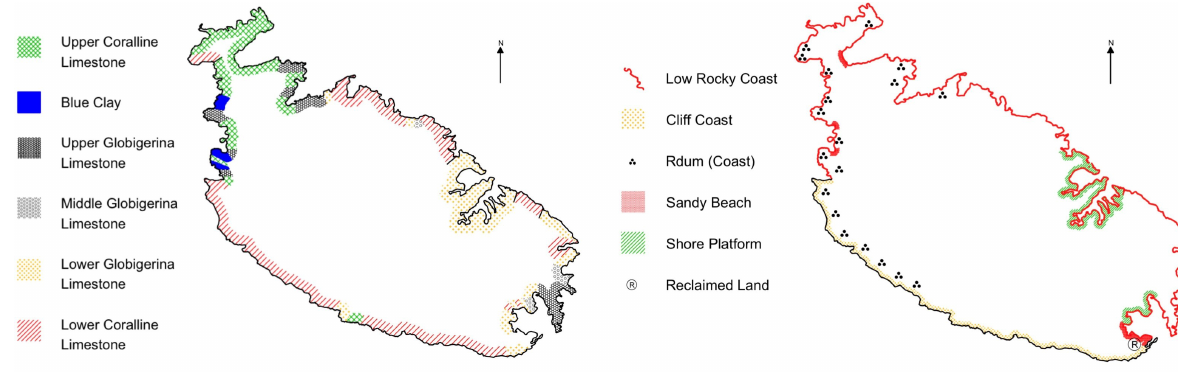
Figure 4. Malta: coastal geology (left) and geomorphology (right) (online version is in